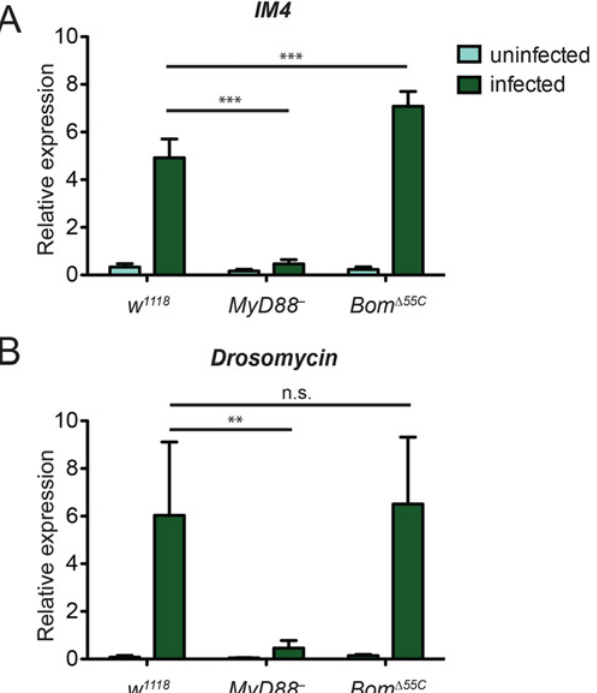
Fig 3. Toll-mediated activation of immune genes is normal in Bom Δ 55C flies. Transcript levels of the Toll- responsive genes (A) IM4 and (B) Drs in flies were measured in the absence of infection and six hours after infection with E . faecalis . Expression was measured by qRT-PCR and normalized to that of the ribosomal protein gene rp49 ( rp49 = 1). Error bars represent SEM. Significance was measured by two-way ANOVA ( ** p < 0.01, *** p < 0.001, n.s. = not significant, p >